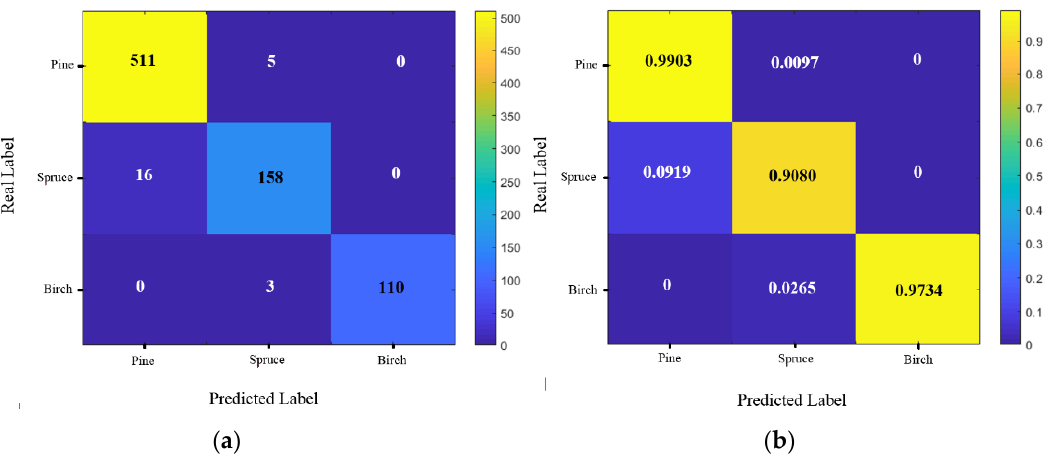
Figure 14. Confusion matrices of the 3D-CNN with only spectral channels (33 bands) ; ( a ) case numbers, ( b ) normalized percentages.